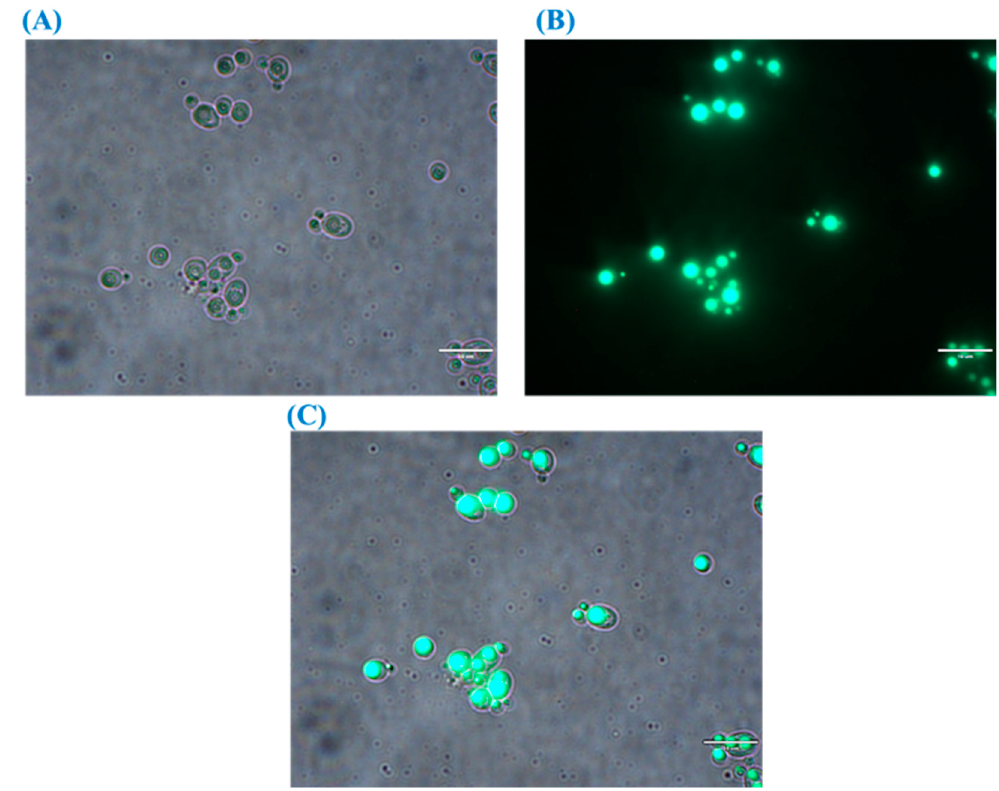
Figure 5. Bright field ( A ) and fluorescence ( B ) and merged images ( C ) showing lipid droplets accumulation in the oleaginous yeast R. kratochvilovae cultivated in CBM.